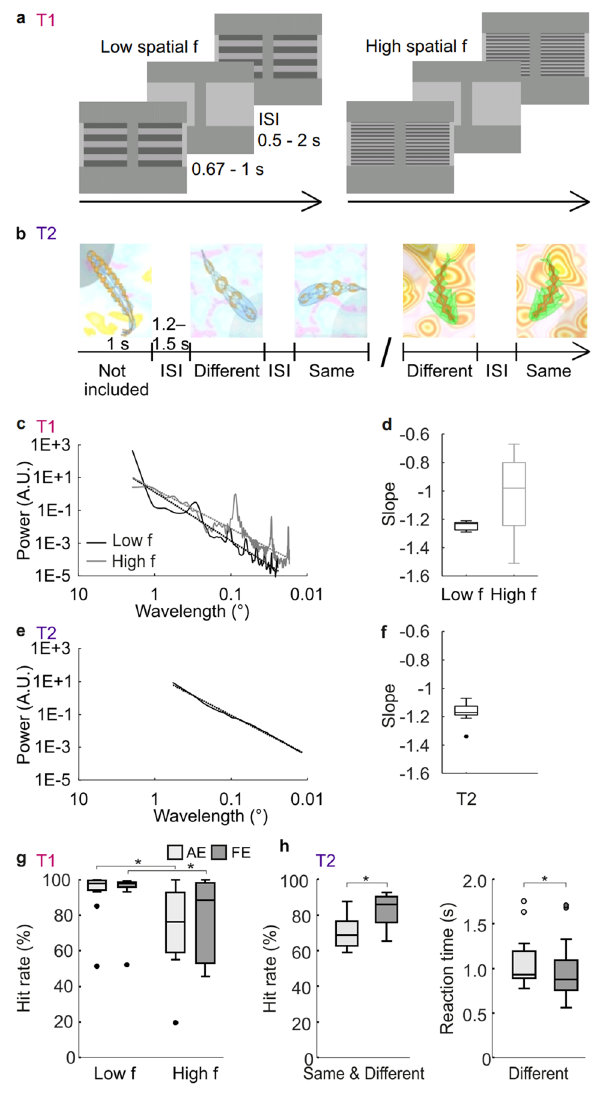
Figure 1. Tasks, stimuli and behavioural performance. ( a ) Schematic illustration of the discrimination task (T1) with low and high spatial frequencies. The subjects’ task was to indicate whether gratings were moving in same or different directions. ( b ) Example trials and stimulus sequences used in change-detection task (T2) shown from two different blocks with different background images. ( c ) Stimulus spectral properties as estimated with radially averaged power spectrum for T1 across stimuli views. Solid lines depict power at spatial wavelength of stimuli images, and dashed lines regression lines which are used to obtain the slopes. ( d ) Slopes of stimuli images’ power spectra for the T1 conditions as estimated with linear regression from the log–log (frequency, power) coordinates. ( e , f ) Same as ( c , d ), but for T2. ( g ) HRs for T1. Stars mark significant difference ( t -test, p < 0.05). ( h ) HRs and RTs for T2. In boxplots median is marked with a line, and the whiskers extend at maximum to 1 × the interquartile